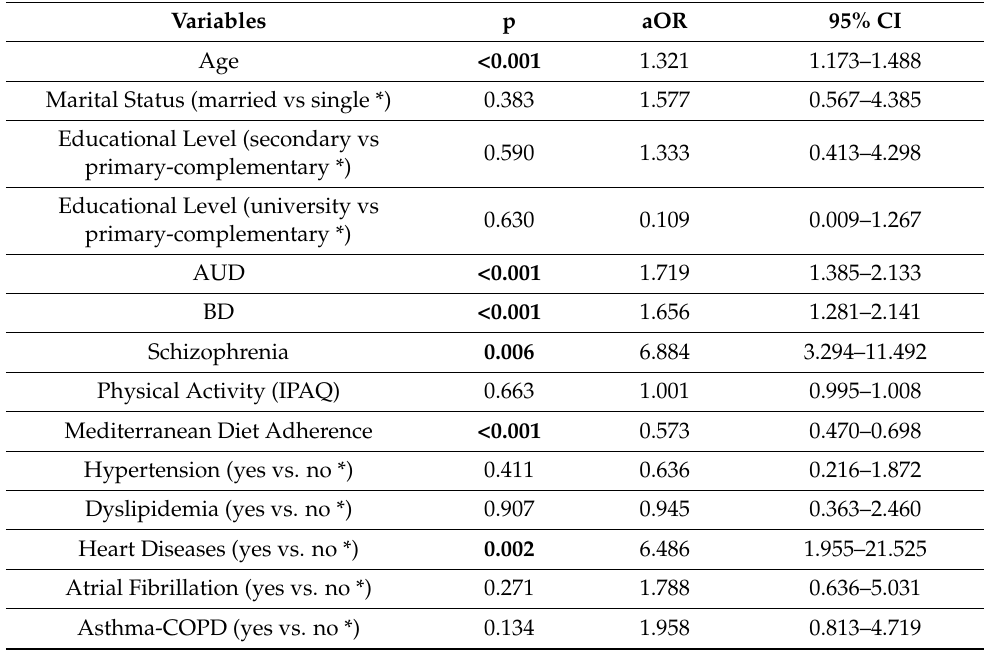
Table 5. Cont. Model 2: Levels of stroke severity (Moderate to Severe/Severe Stroke vs No